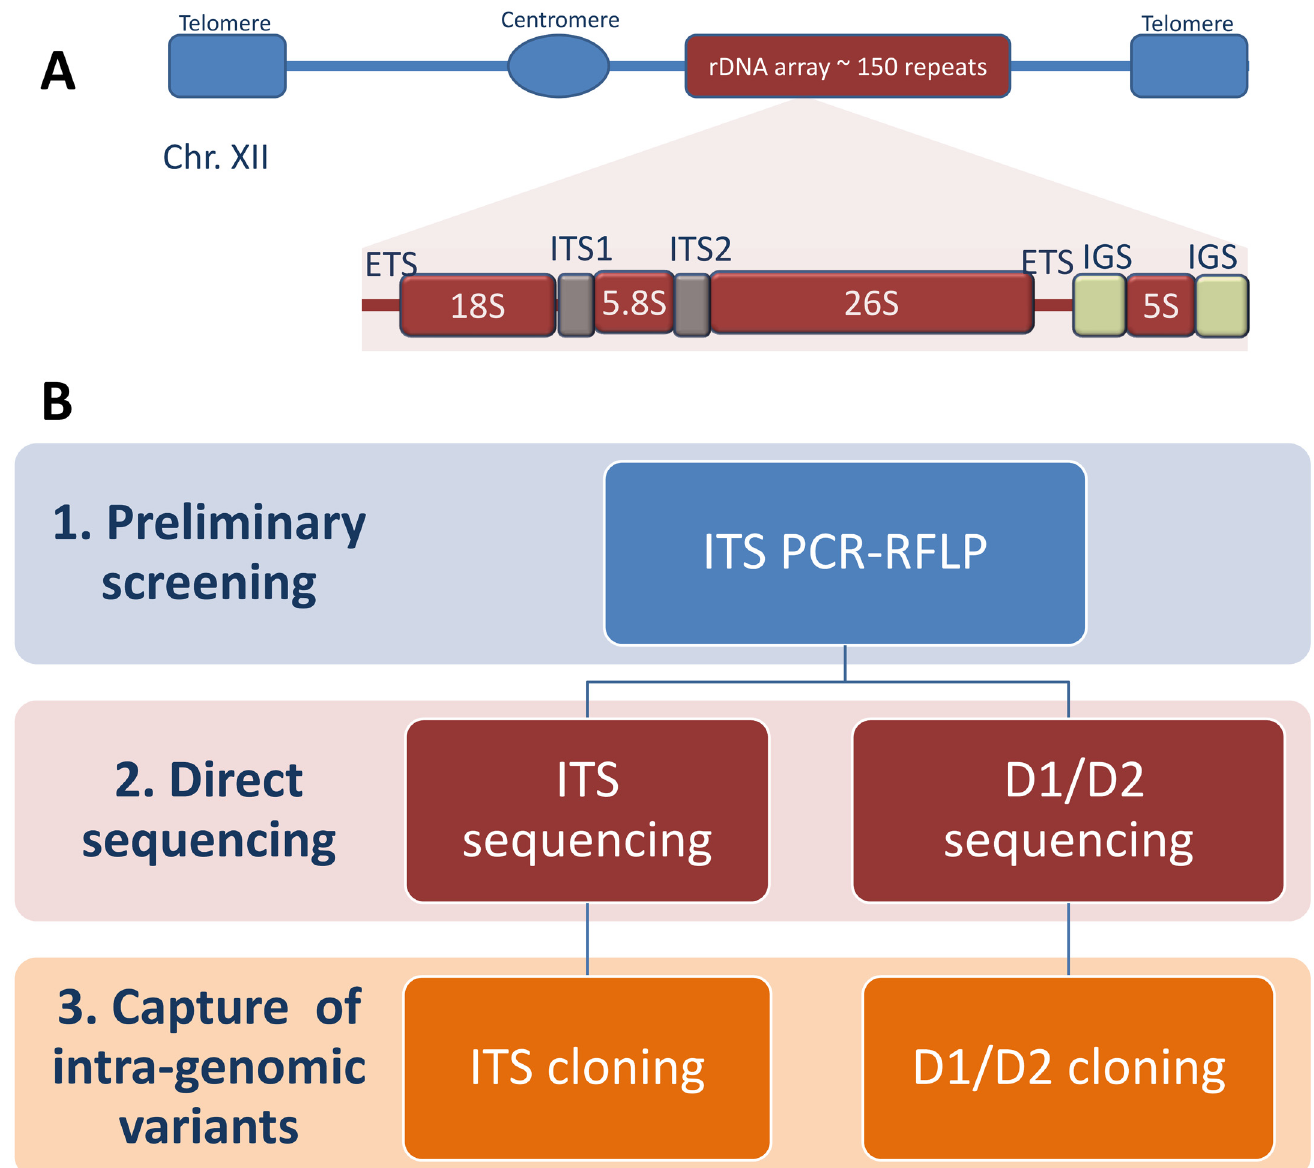
Fig 1. Overview of the experimental design. A) The rDNA locus in chromosome XII of the model yeast Saccharomyces cerevisiae , and a schematic representation of its rDNA unit. Boxes and lines represent the rDNA repeat structure and are not to scale. B) A three-step strategy is used to identify intra-genomic variants within a pool of 43 Z . rouxii related strains. Abbreviations: ETS, external transcribed spacer; ITS, internal transcribed spacer; IGS, intergenic spacer.